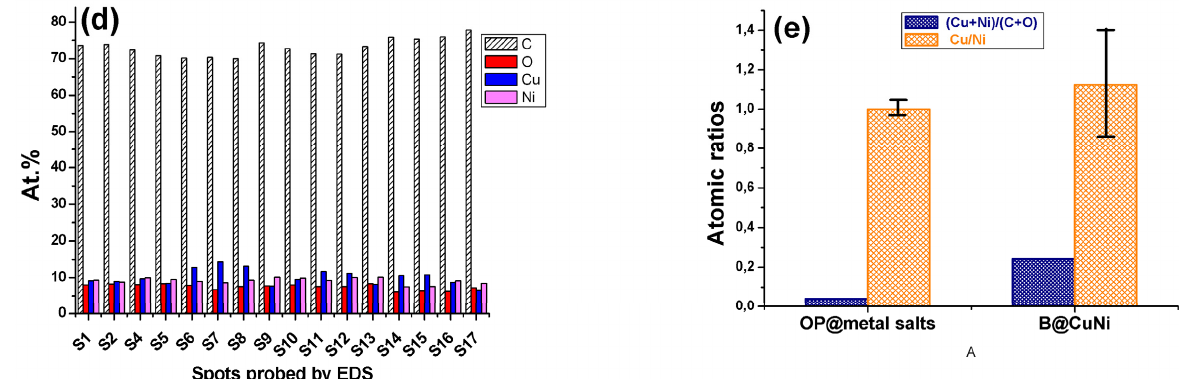
Figure 3. EDX spectra of ( a ) olive pit powder particles, OPs; ( b ) OPs impregnated with metal salts (copper and nickel nitrates), and ( c ) B@CuNi. SEM images show spots probed for the acquisition of EDX spectra. EDX quantification: ( d ) elemental analysis of C, O, Cu and Ni detected at 15 spots of B@CuNi surface; and ( e ) (Cu+Ni)/(C+O) and Cu/Ni atomic ratios averaged over 15